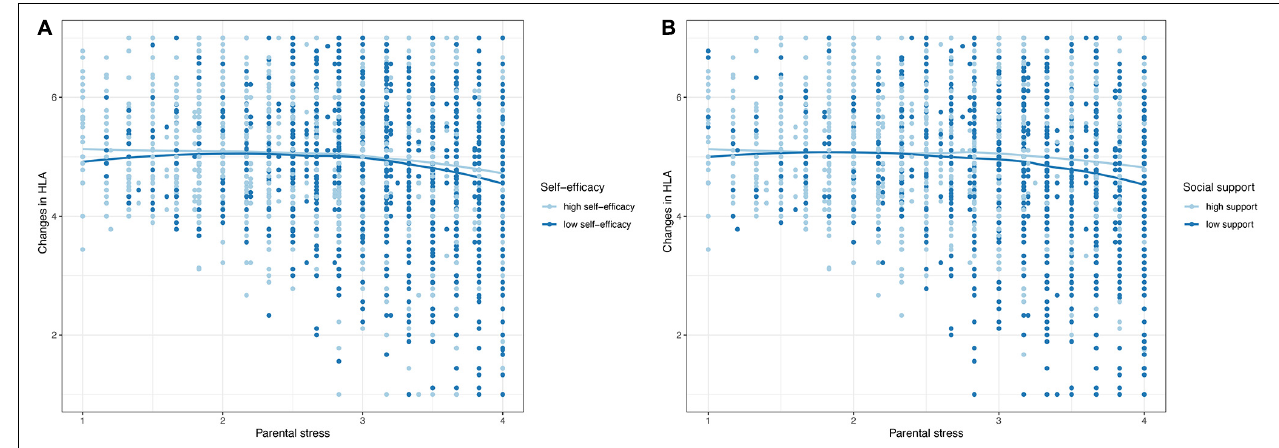
FIGURE 2 | LOESS plots for the relation between perceived parental stress and changes in HLA moderated by (A) parental self-efficacy and (B) perceived